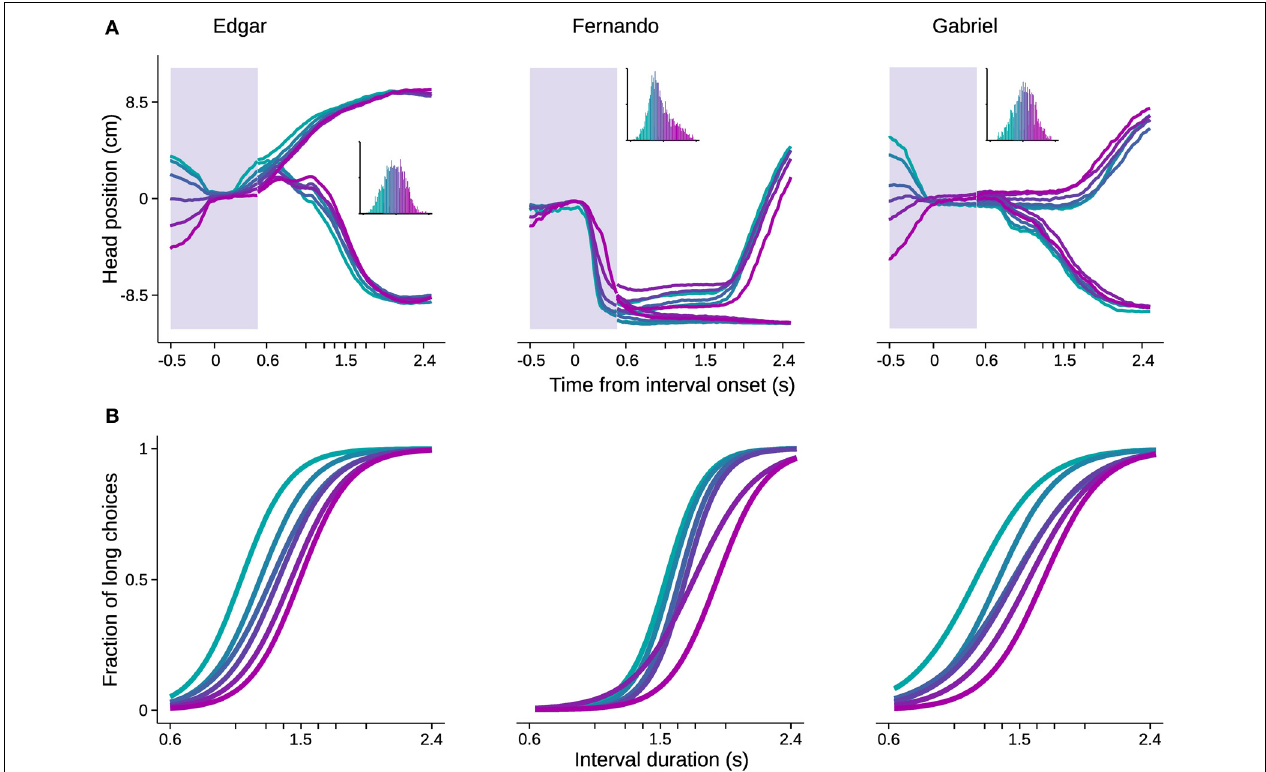
FIGURE 6 | Head trajectory reveals categorization bias. Trajectories of head position in a 1 s time window centered on interval onset were used to predict choice. The probability of trajectories conditional on choice was fitted with Gaussian mixture models. The fitted distributions were used to estimate choice probability from single trial trajectories. Trials were then binned by choice probability.